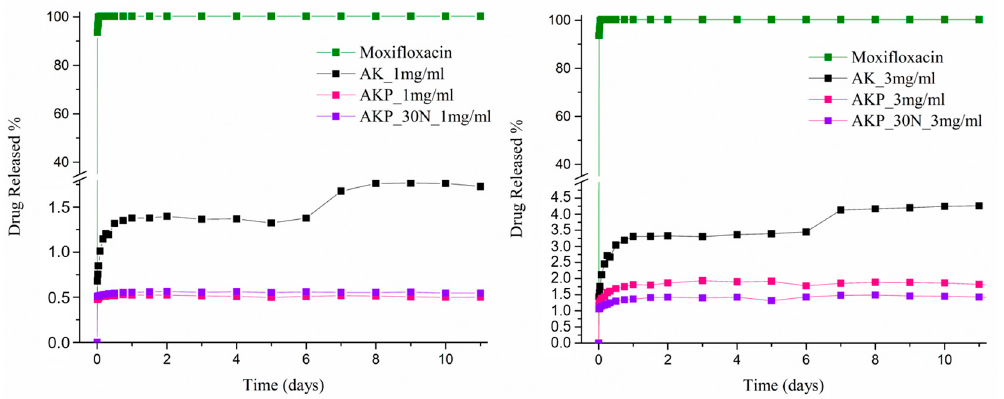
Figure 22. In vitro MOX release rate from the scaffolds at pH 7.4 for 1 and 3 mg/mL concentrations.